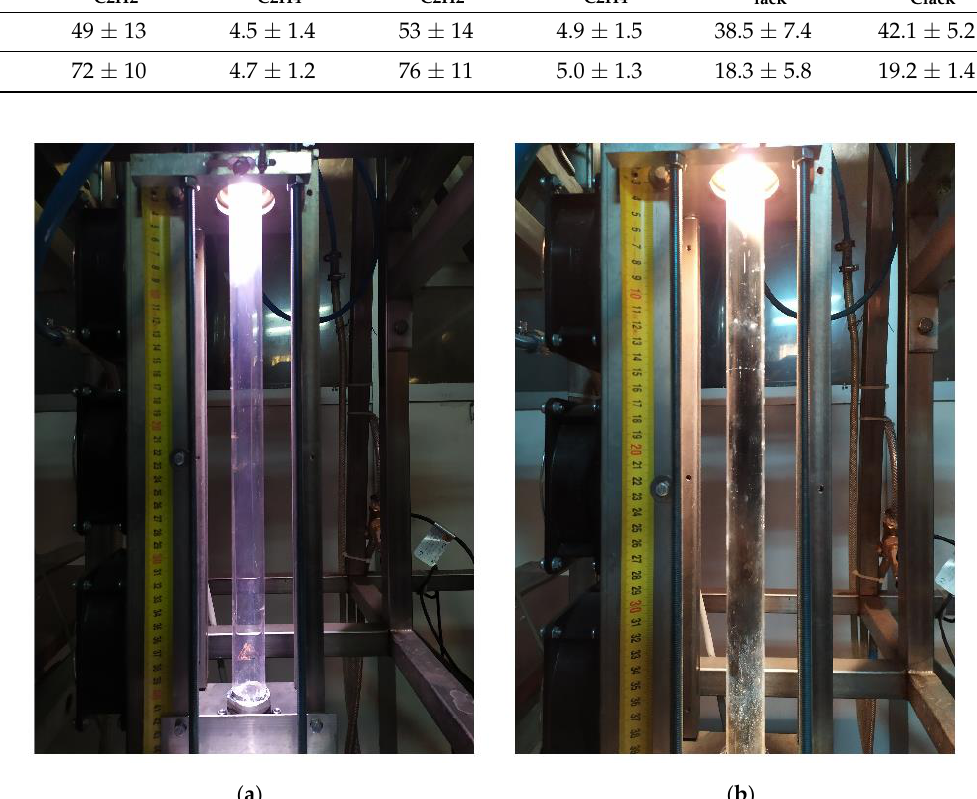
Figure 8. The quartz tube of the reactor during tests 4:1 N 2 ( a ) and 4:1 Ar ( b ). Table 2. Nitrogen impact on the process parameters.